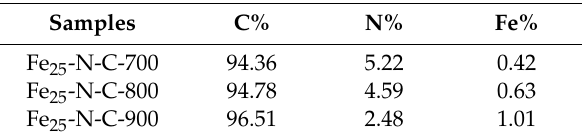
Table 2. X-ray photoelectron spectroscopy (XPS) element quantification of Fe 25 -N-C-Y catalysts (Y = 700, 800, 900 ◦